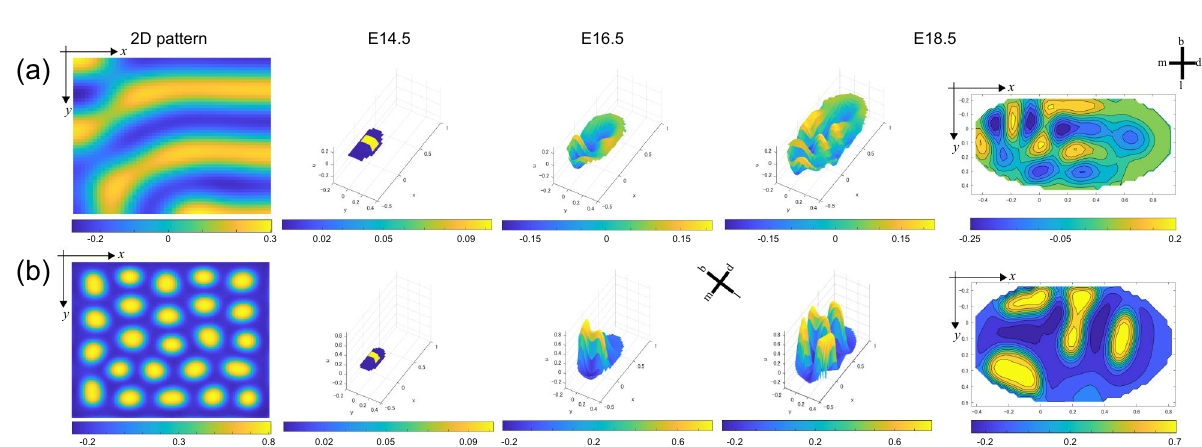
Figure 4. Simulation of molar morphogenesis. The parameters for UM that make stripe patterns are the following: ( a ) f u = 0.4, f v = − 1, q = 0, c = 1, g u = 0.4, g v = − 0.44, d u = 0.006, d v = 0.06. The parameters for LM that make spot patterns are the following: ( b ) f u = 0.2, f v = − 0.6, q = 0.45, c = 0.6, g u = 0.2, g v = − 0.32, d u = 0.006, d v = 0.06. The 2D images of stripe and spot patterns are formed after letting the system settle from an initially random configuration under the above parameter sets. Simulated concentration of activator ( u ) is represented in 3D at E 14.5, E 16.5, and E. 18.5. The final plain colormaps are also shown at E 18.5. The unit of x and y axis is in mm. m mesial, d distal, b buccal, l